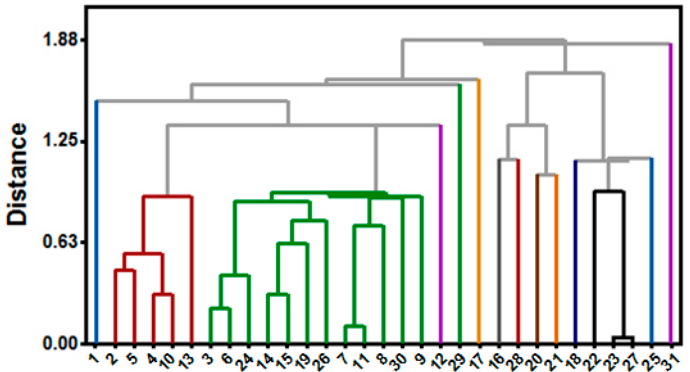
Figure 13. Dendrogram used to investigate chemical similarity of RIPK2 inhibitors.